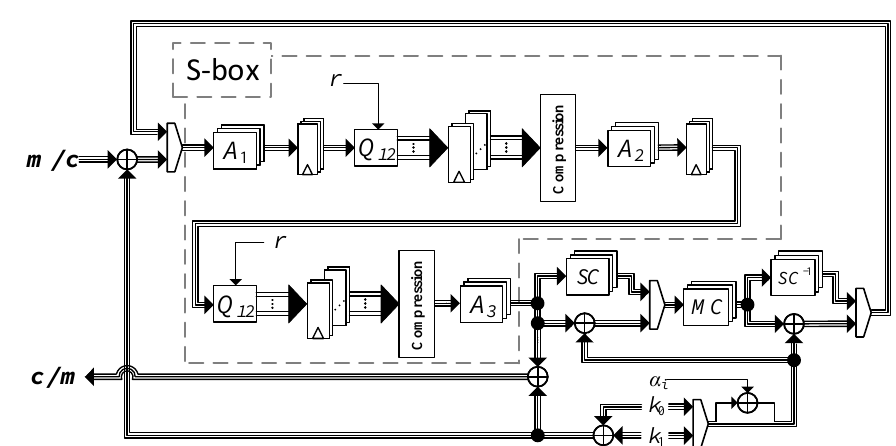
Figure 7: Design architecture of our round-based second-order Midori -64 encryp- tion/decryption